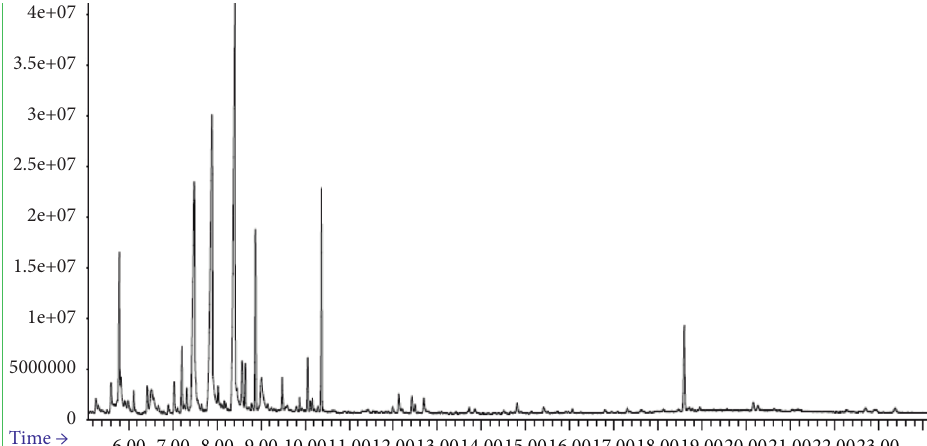
Figure 2: Chromatogram of Artemisia herba alba Asso . essential oil.